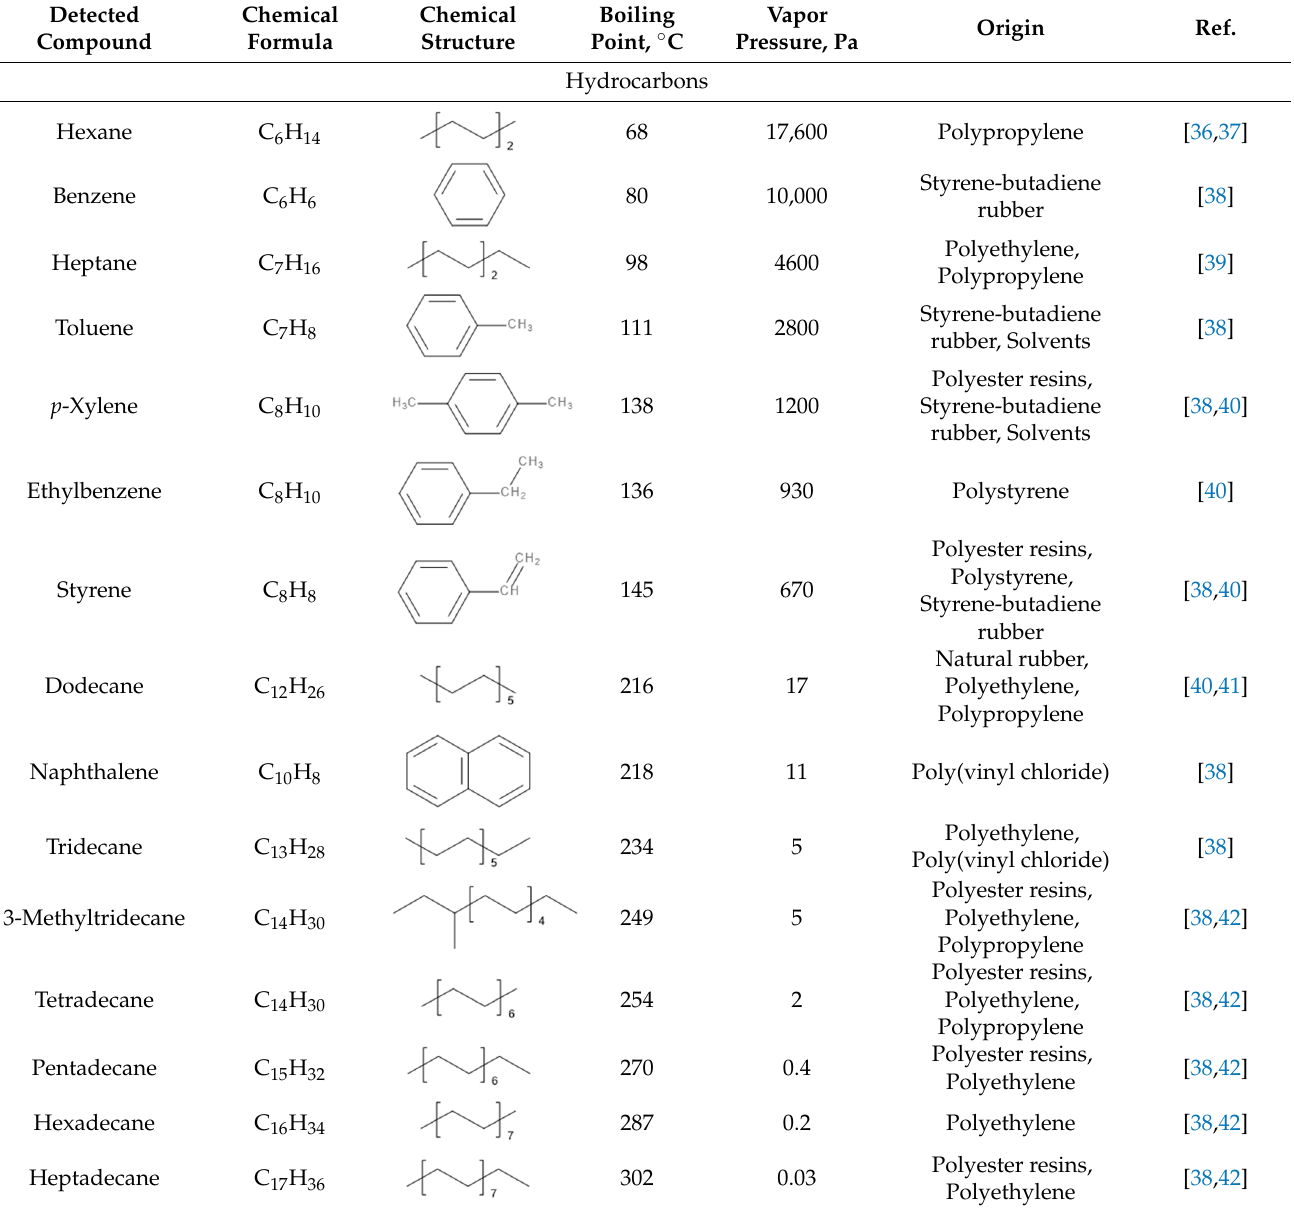
Table 1. Compounds detected in the air during a background check of our laboratory hall.